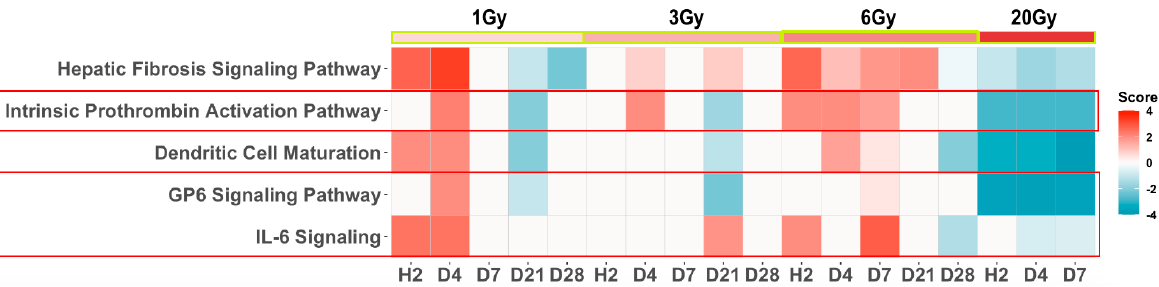
Figure 4. Pathway enrichment analysis of SDTGs ( p ≤ 0.05 and FC ≥ 2) from all TPs and IR doses (pathways z-scores > Abs 2.75 and − log p > 4 or p <0.0001). Pathways in red boxes contribute to hematological homeostasis.